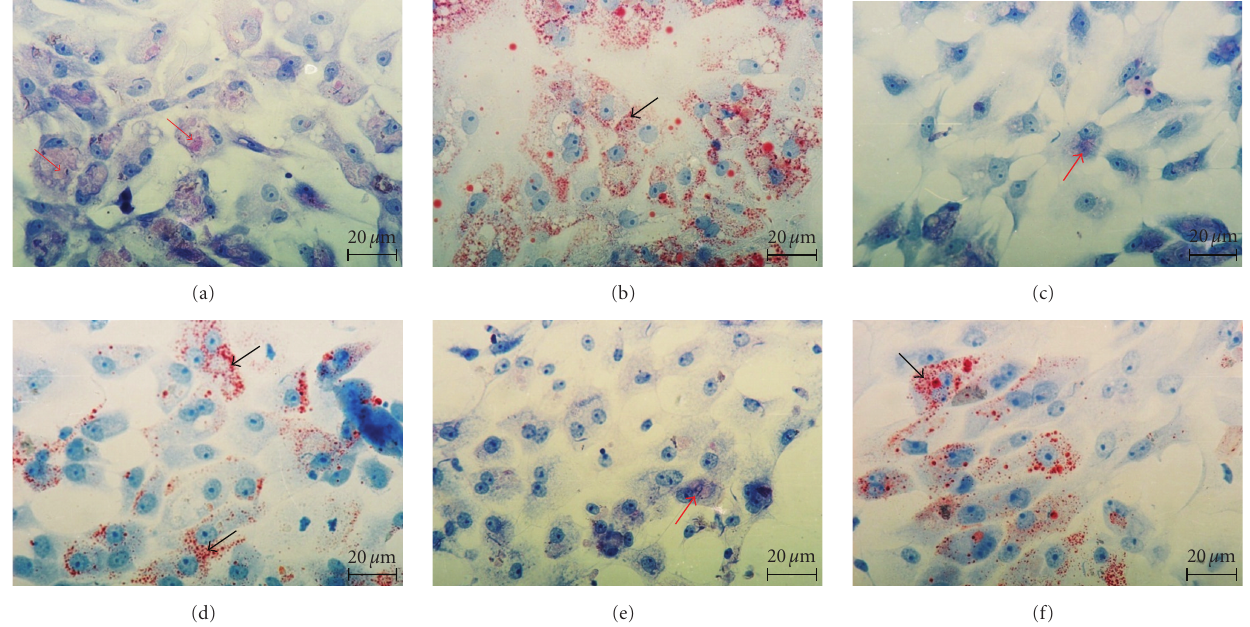
Figure 3: The 5th-day culture of epididymal epithelial cells: epididymal epithelial cells cultured in medium with DHT. The cells form confluent monolayer. The cytoplasm is rich in PAS-positive substances (red arrows) and glycogen (a) and lipid droplets (black arrows) (b). Epididymal epithelial cells are cultured without DHT. The cells stellate in the shape connected by cytoplasmic processes. The cytoplasm are poor in PAS-positive substances and glycogen (c) and lipid droplets (black arrows) (d). Epididymal epithelial cells are cultured without DHT in supplementation with 0.8 IU/mLFSH. The cytoplasm is poor in PAS-positive substances (red arrow) and in glycogen (e), and rich in lipid droplets (black arrow) (f). (a), (c), and (e)—PAS; (b), (d), and (f)—ORO: Scale bar: 20 μ m.